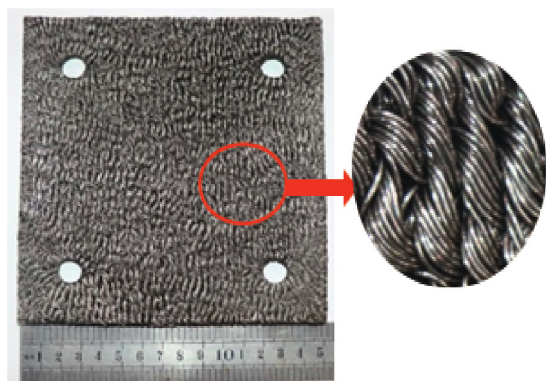
Figure 1: Picture of platelike EMWM specimen.